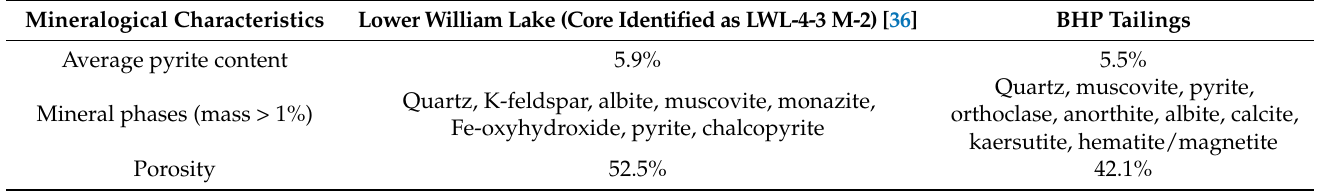
Table 1. Comparison between the Lower William Lake and BHP Billiton tailings’